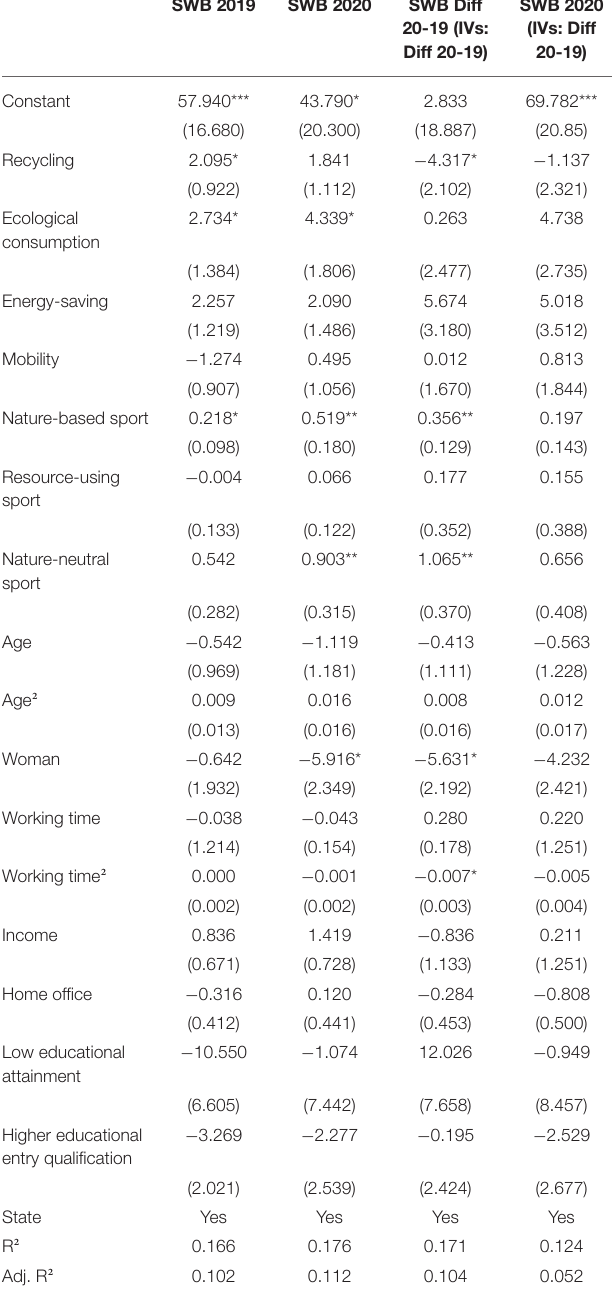
TABLE 6 | Regression analyses for SWB ( n =